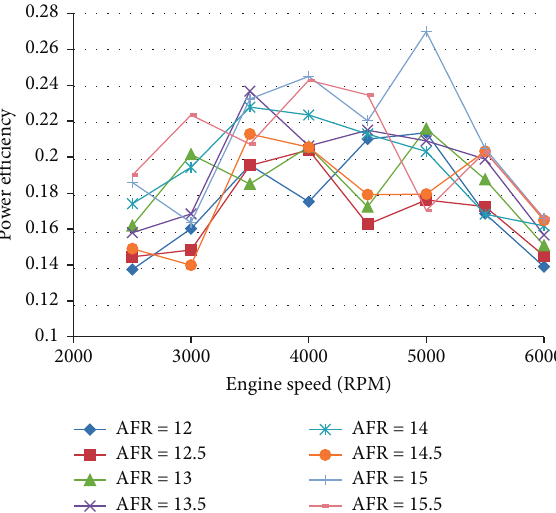
Figure 12: Output torque at different engine speeds.